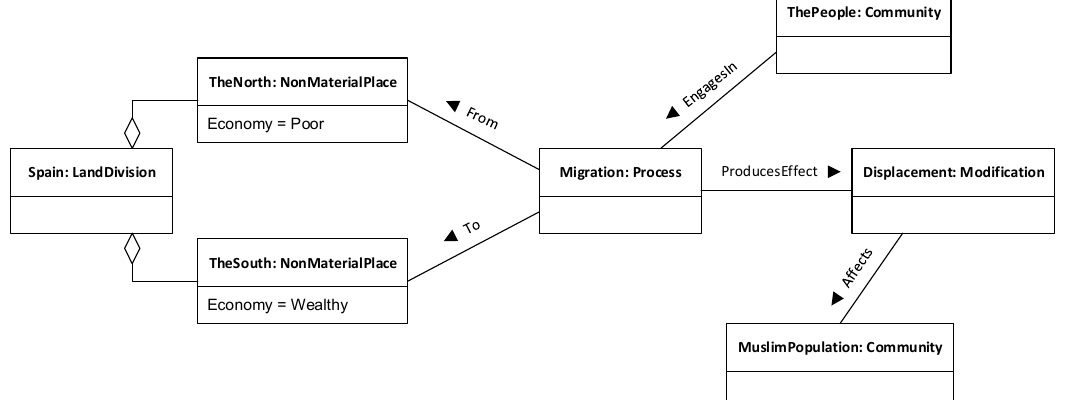
Figure 3. A ConML diagram showing a domain model for the text fragment mentioned above. Boxes represent entities in the world. For each one, an identifier and a category are given, separated by a colon. For some entities, values are stated, such as in the case of Economy = Wealthy for TheSouth . Lines connecting boxes stand for links between entities and are labelled accordingly.